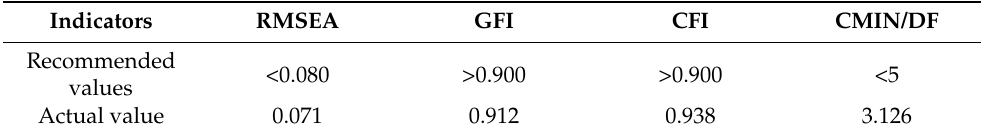
Table 8. Results of model fit